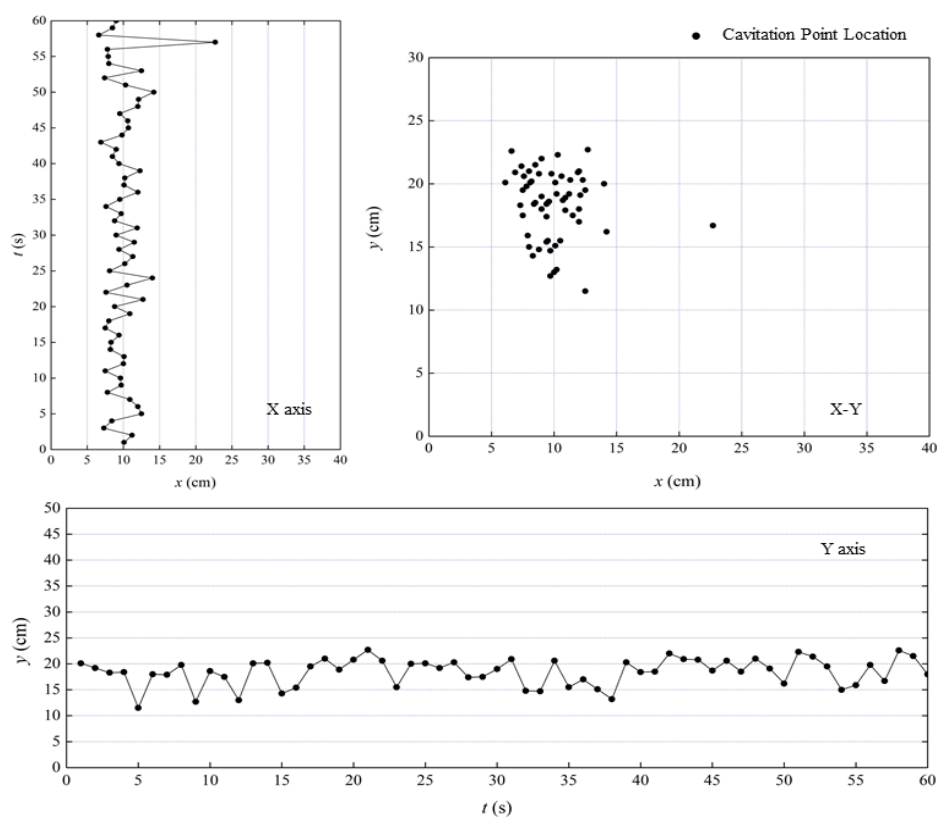
Figure 10. Cavitation point scatter diagram of a submerged horizontal vortex.